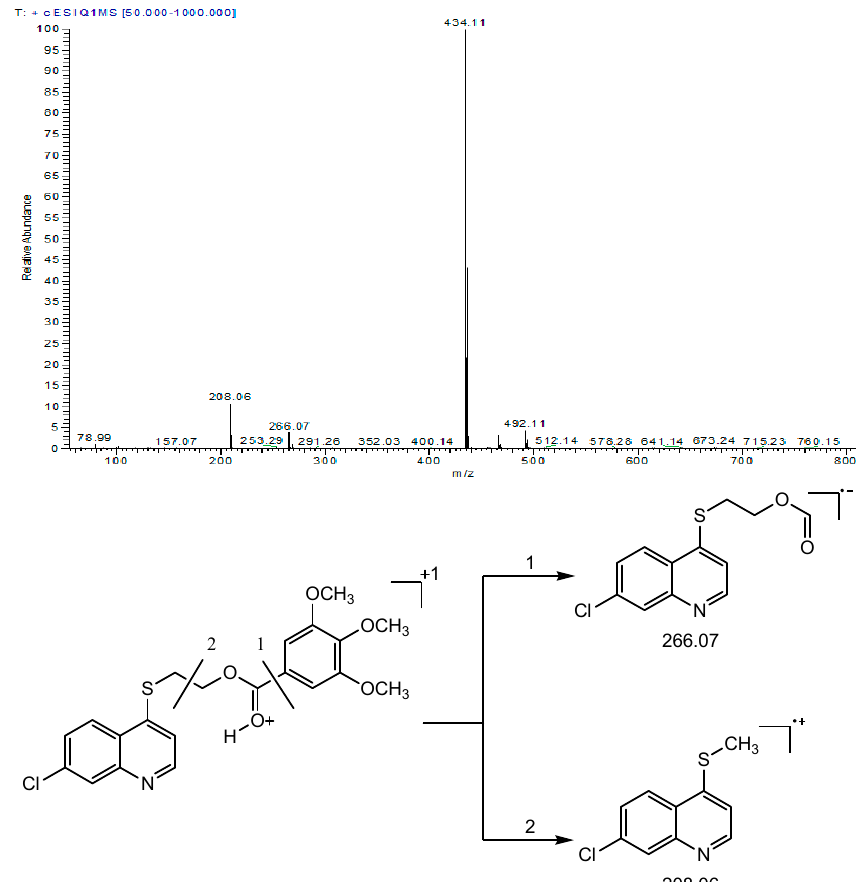
Figure 5. Mass spectrum of 14 and proposed fragmentation patterns.